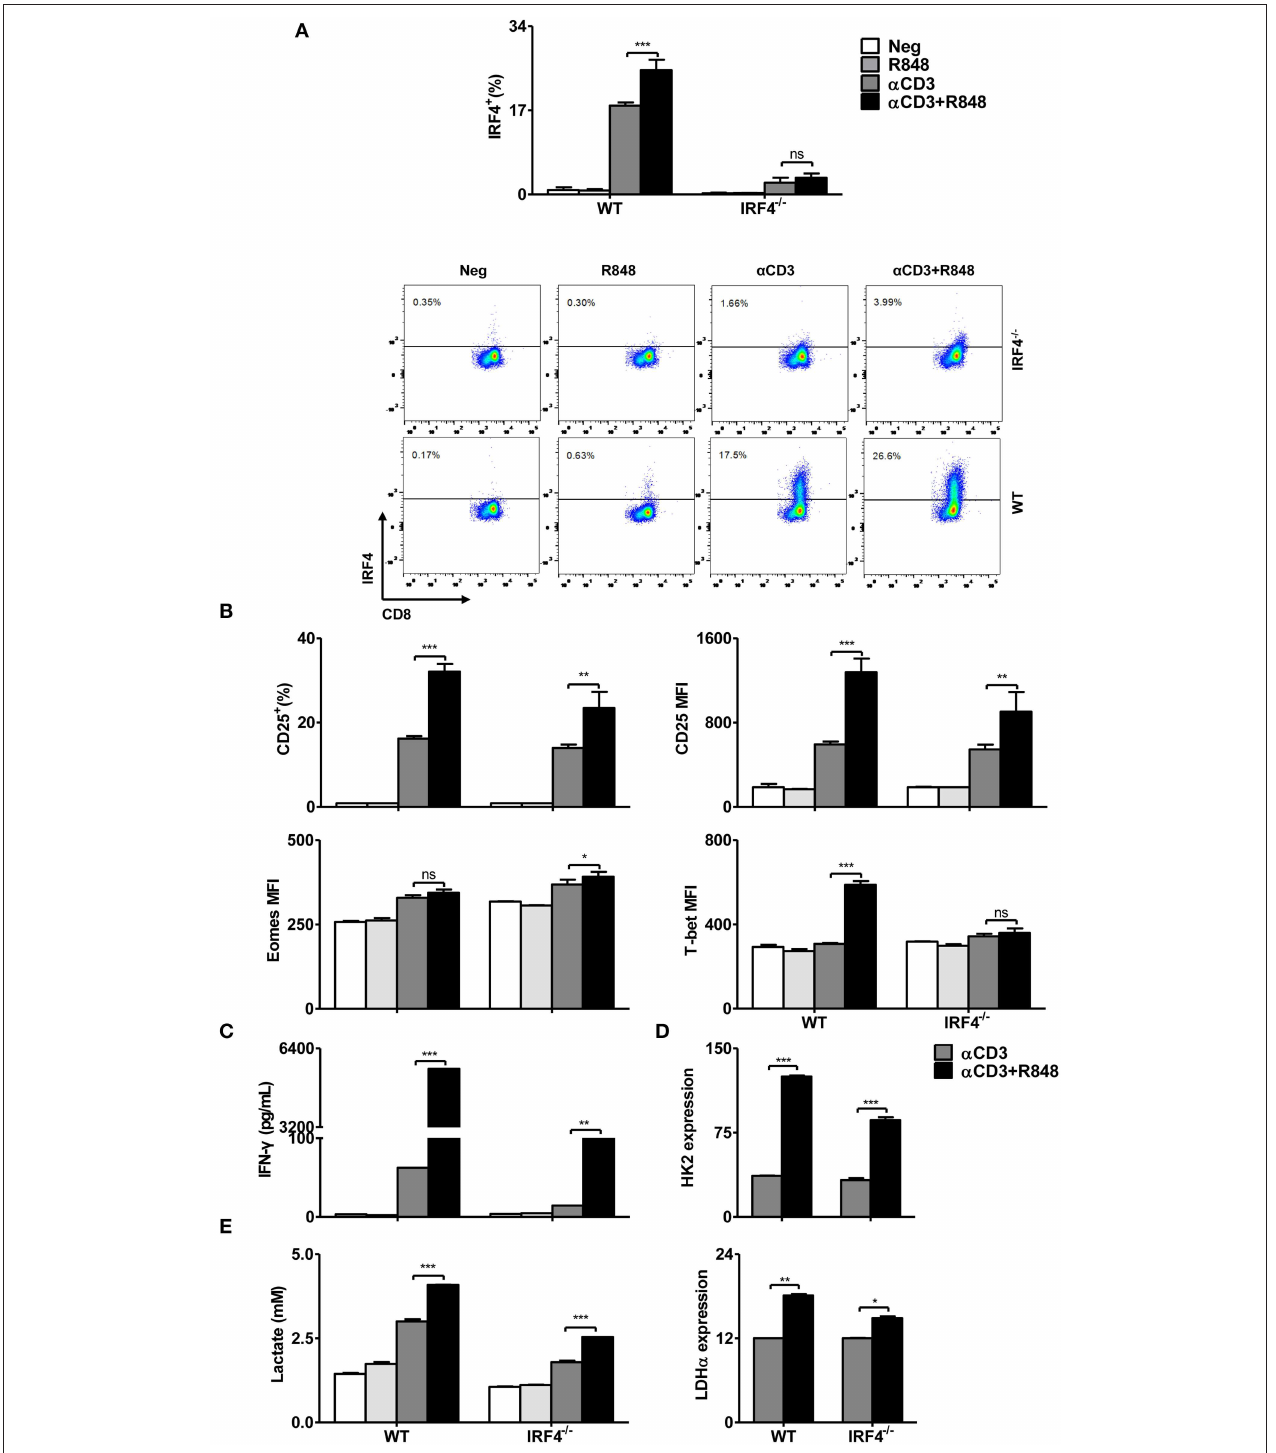
FIGURE 6 | R848-stimulated metabolic and functional changes in CD8 + T cells are partly dependent on the transcription factor IRF4. Purified CD8 + T cells from WT or IRF4 − / − mice were stimulated with α CD3 antibody (5 µ g/mL) or/and R848 (10 µ g/mL) for 24h. (A) Representative dot plots of IRF4 expression in CD8 + T cells as detected by flow cytometry. (B) The expression of CD25, T-bet, and Eomes in CD8 + T cells was measured by flow cytometry. (C) IFN- γ production by CD8 + T cells from WT and IRF4 − / − mice was detected by a specific ELISA. (D) The expression of HK2 and LDH α was quantified by real-time RT-PCR. (E) Lactate production by CD8 + T cells was measured by a specific enzyme assay. Data are representative of three independent experiments. All data are presented as mean ± SD. The statistical relevance was determined by Two-way ANOVA: * p < 0.05; ** p < 0.01; *** p < 0.001; ns, not significant.